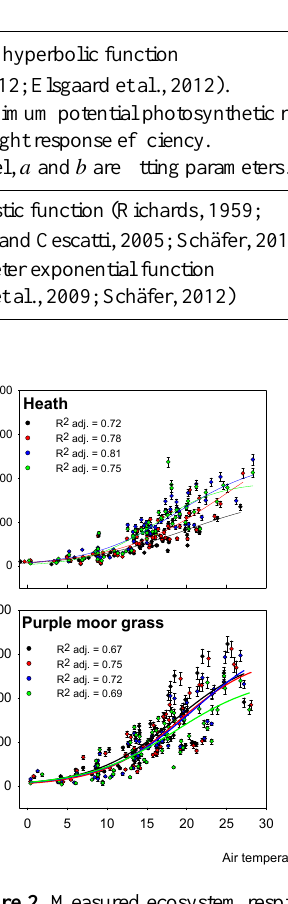
Figure 2. Measured ecosystem respiration (Reco) as a function of air temperature. Points indicate fluxes ± standard error of the flux calculation. The replicate plots of each site are shown in differ- ent colors. Lines represent the fits to raw data using Reco 1 model. For the industrial extraction site a linear regression was used. The ) goodness-of-fit is indicated ( R 2 adjusted